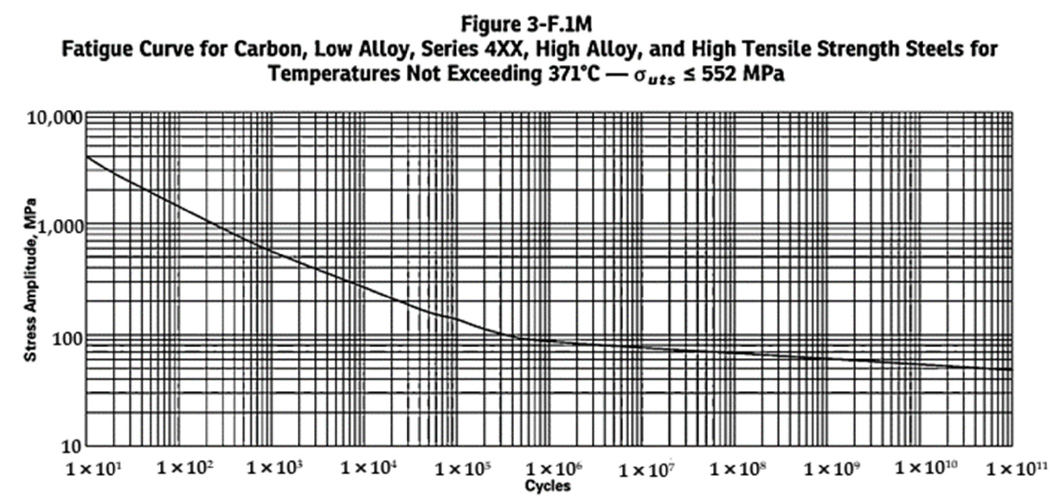
Figure 12. Fatigue curve for carbon, low alloy, series 4XX, high alloy and high tensile strength steels for temperatures not exceeding 371 °C [25].